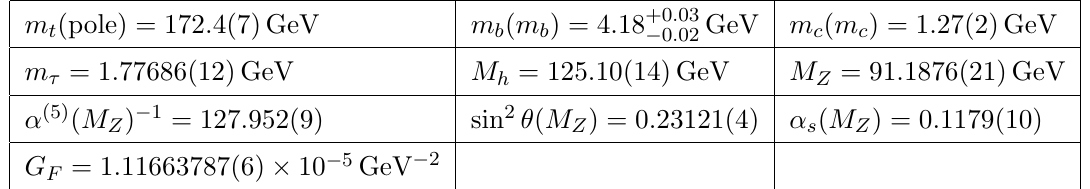
Table 1. Numerical input used to determine the initial conditions of the coupling constants. All values are taken from ref.